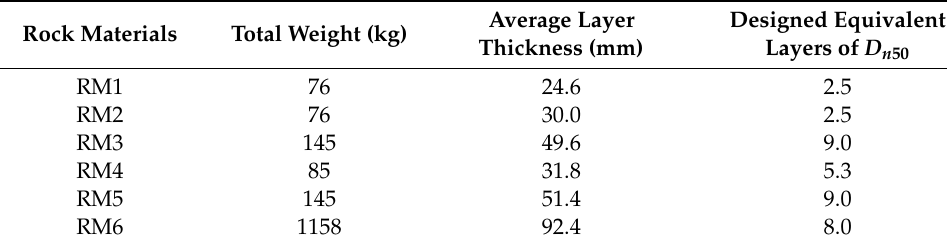
Table 1. Conditions of rock materials in the test cases.